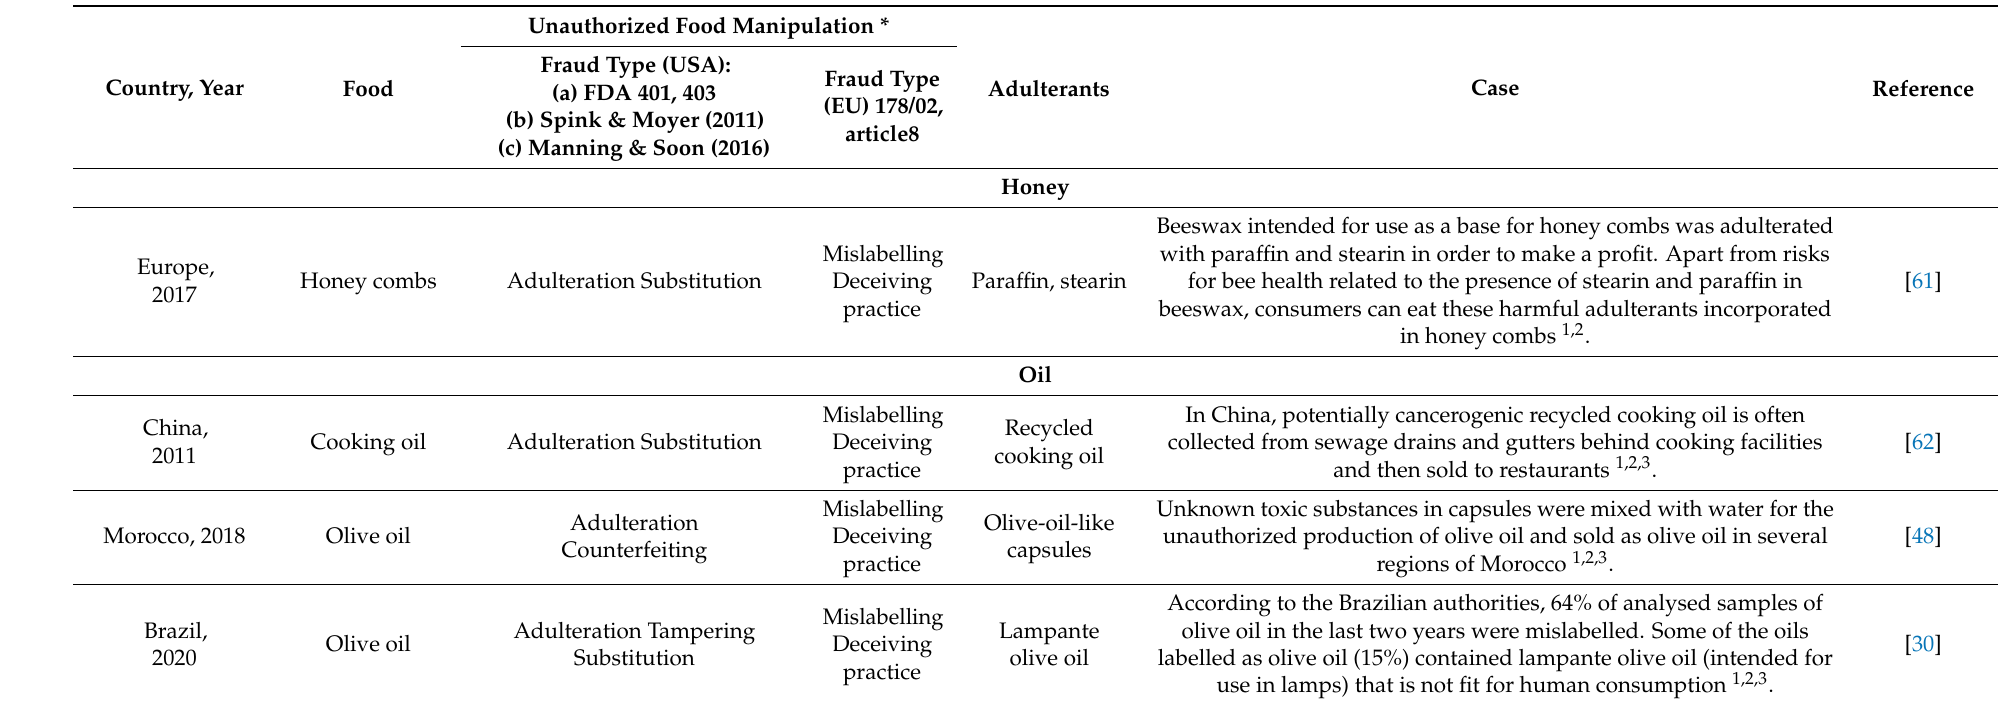
Table 3. Unauthorized Food Manipulation regarding contamination in food products,